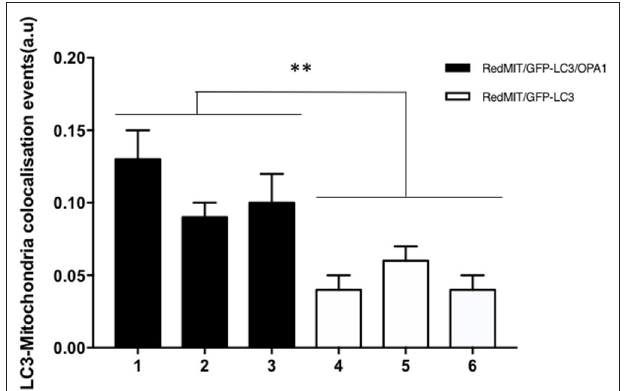
FIGURE 5 | Baseline mitophagy is increased by the OPA1 Q285STOP mutation in mouse splenocytes. Fixed splenocytes (1,000–5,000 per mouse) from three RedMITGFP-LC3-OPA1 Q285TOP mice (designated 1–3) and three RedMIT-GFP-LC3 mice (designated 4–6) mice were prepared and analyzed using the Imagestream (Amnis) system, error bars are SE of technical replicates. In line with the results observed in MEFs, colocalization between mitochondria and LC3 is increased in the OPA1 mutant mice. ( t -test, ** p <